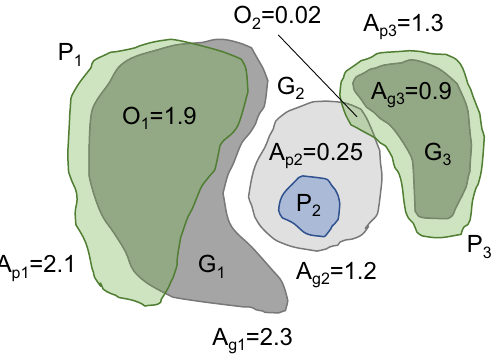
Figure 4. Illustrative example of SQ and RQ computations, with predictions in green (true positive) or blue (false positive) and annotations in solid gray (true positive) or light gray (false